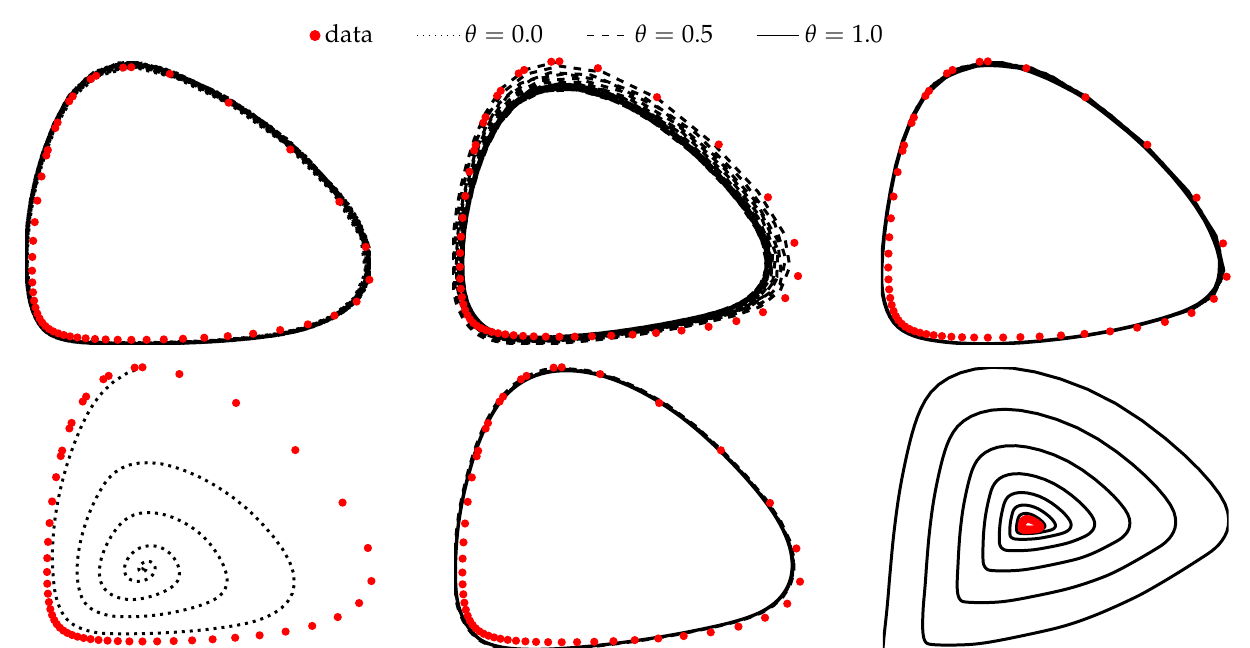
Figure 11. ( Top ) A single trajectory generated by three trained implicit residual networks for the problem in Example 3 on the time interval t ∈ [ 0,200 ] ; ( Bottom ) continuous-time trajectory generated by the learned vector fields of these residual networks on the same time interval.